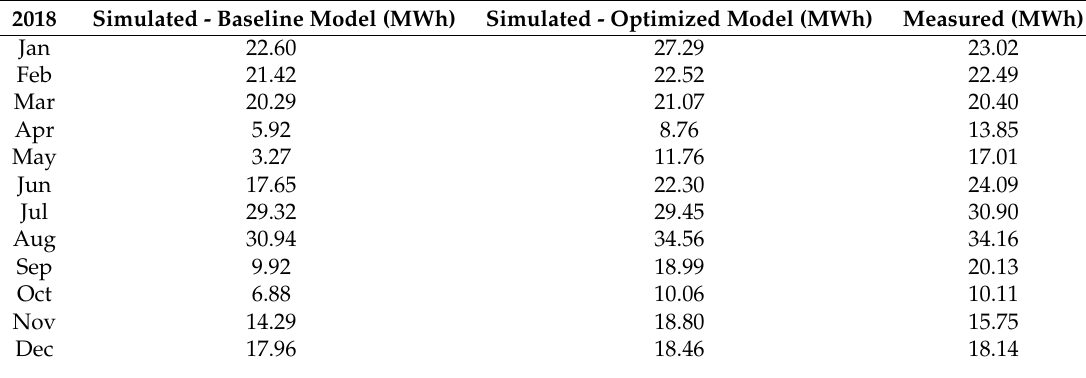
Table 2. Monthly measured HVAC electrical energy consumption values and the corresponding simulated ones obtained from the baseline and optimized models for